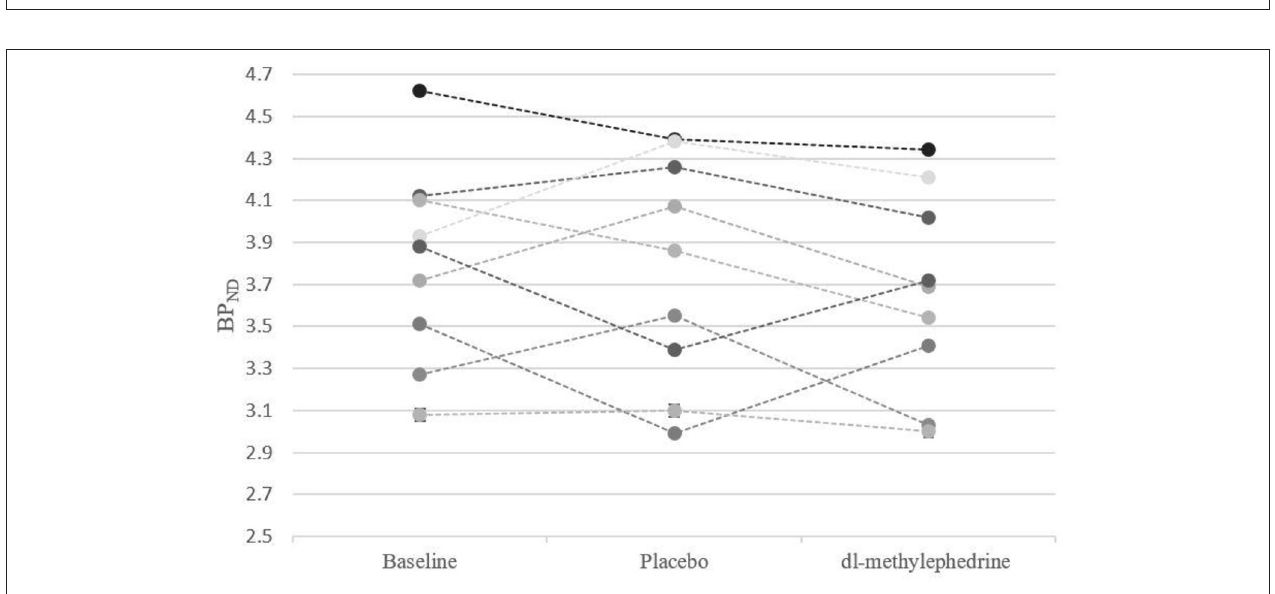
FIGURE 2 | BP ND in caudate for each subject at baseline, placebo, and 60mg of dl-methylephedrine.